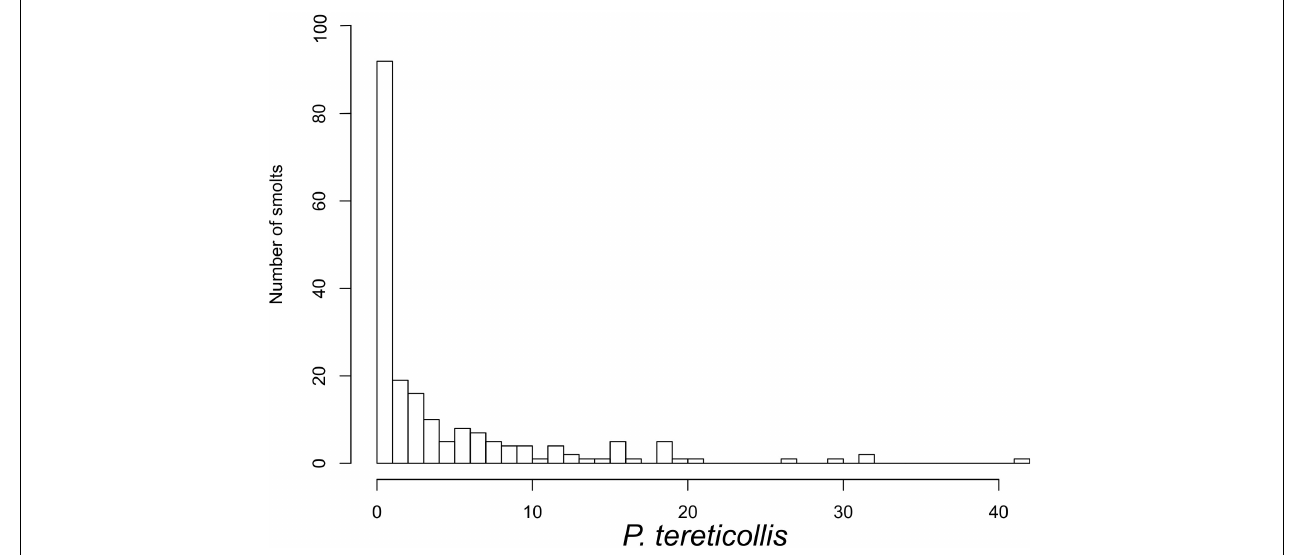
FIGURE 1 | Histogram of P. tereticollis abundance for all smolts used in experiment ( n = 198).